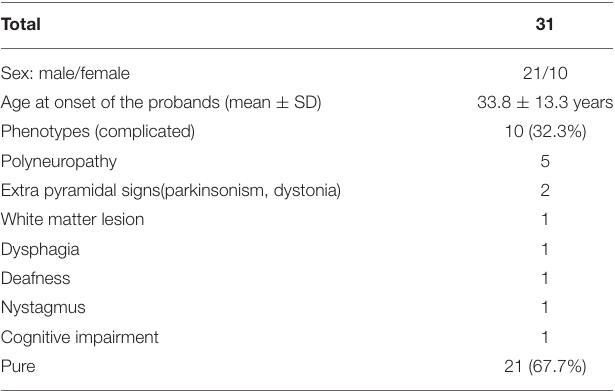
TABLE 1 | Clinical features of the HSP cohort in this